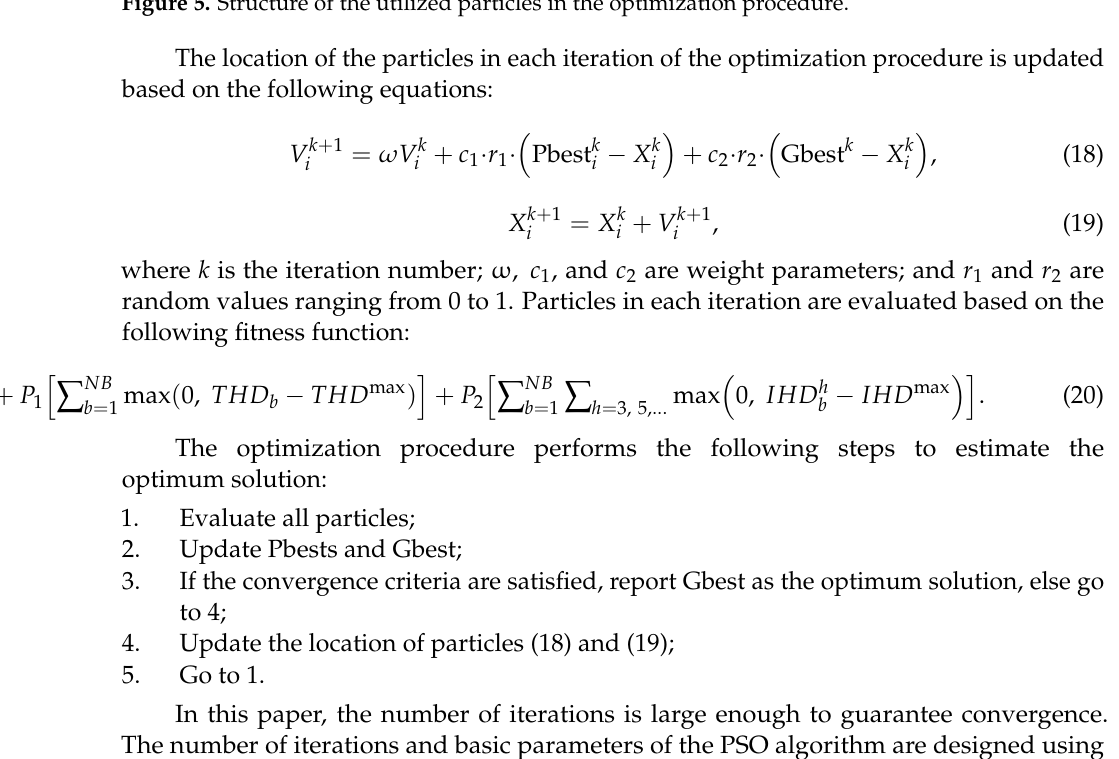
Figure 5. Structure of the utilized particles in the optimization procedure.